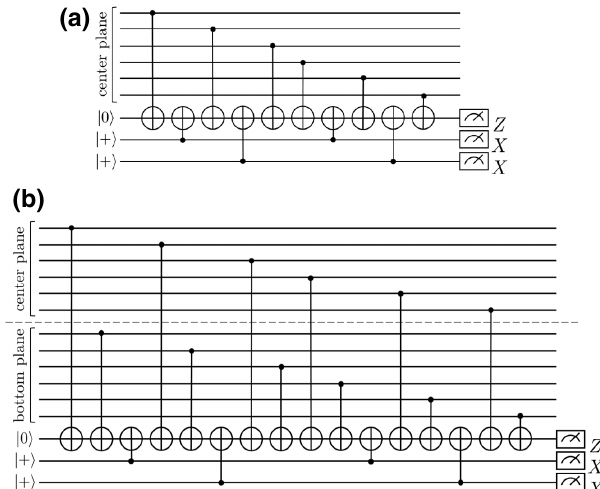
FIG. 9. (a) An example of a flag circuit for measuring the f generator with two flag ancillas. (b) A flag circuit for measur- ing the corresponding v generator. The circuit is obtained by replacing each data CNOT gate that couples q j with the syndrome ancilla by two data CNOT gates that couple q j and q n the syndrome ancilla.